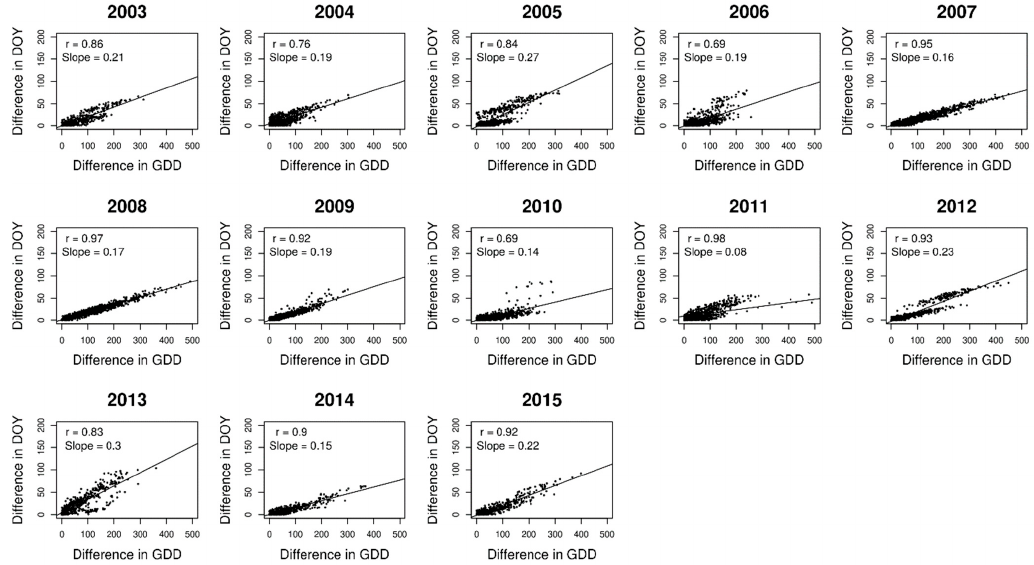
Figure 3. Linear regression lines fitted between the difference in observed flowering DOY (number of days) and the difference in modelled GDD (number of degree days) for pairs of spatially connected observations of lesser celandine flowering onset (see Figure 1). Correlation coefficient and rate of spatial change in DOY per unit of GDDs (i.e., slope of regression line) are given for each observation year.